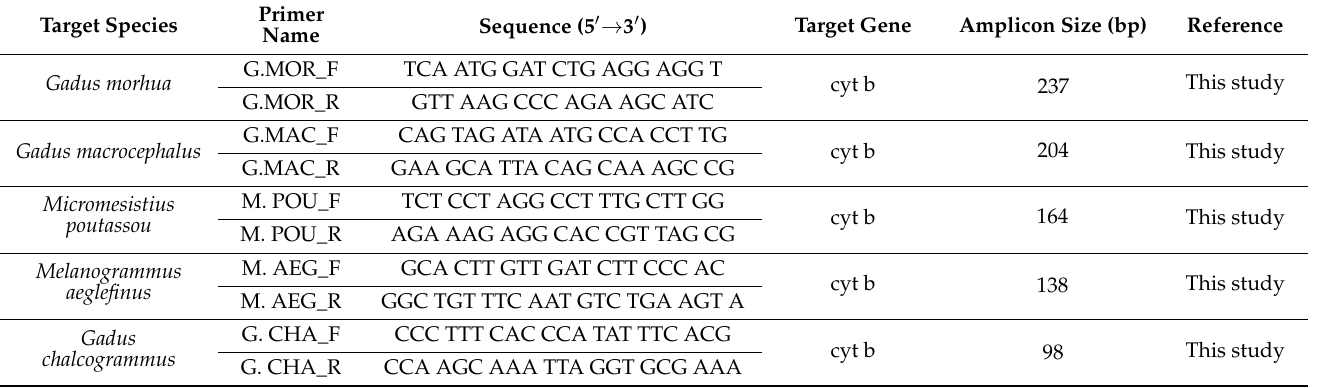
Table 1. Primers used in this